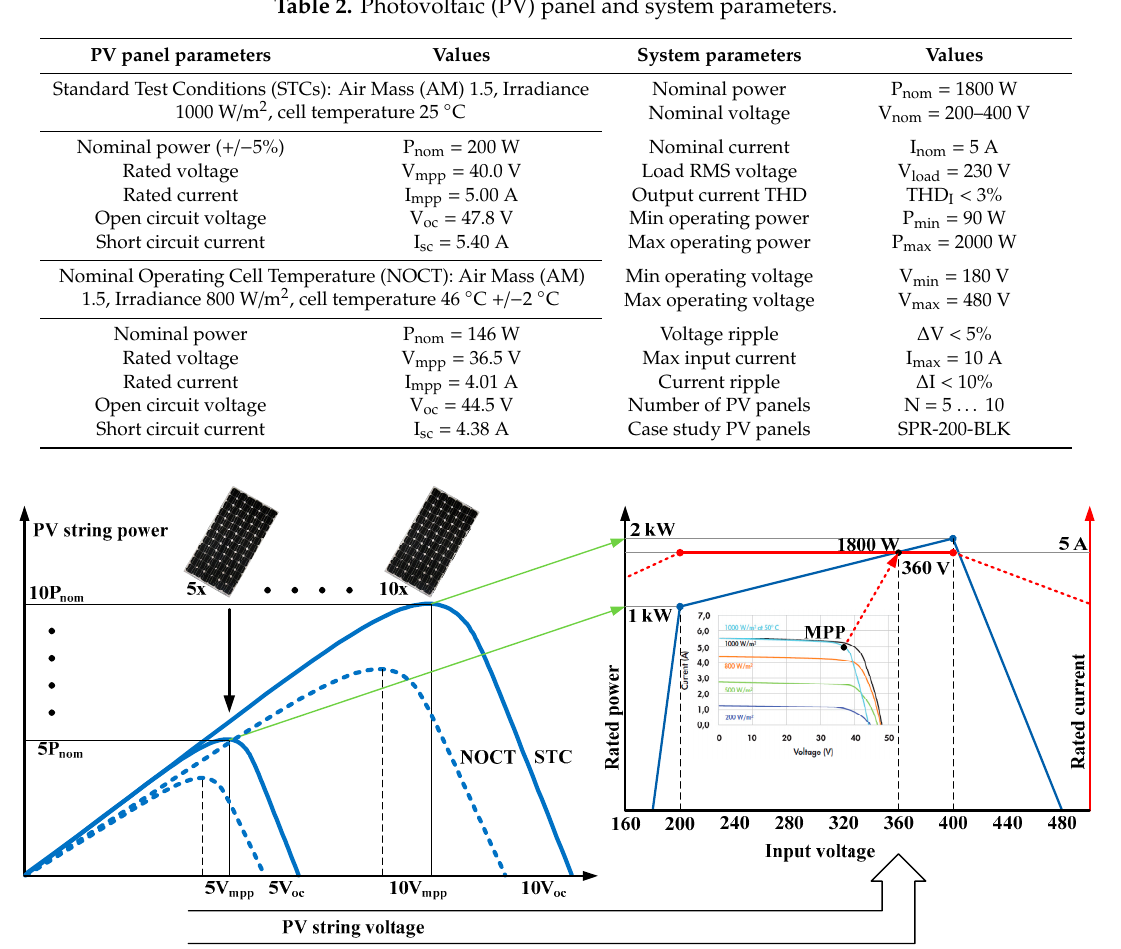
Table 2. Photovoltaic (PV) panel and system parameters.